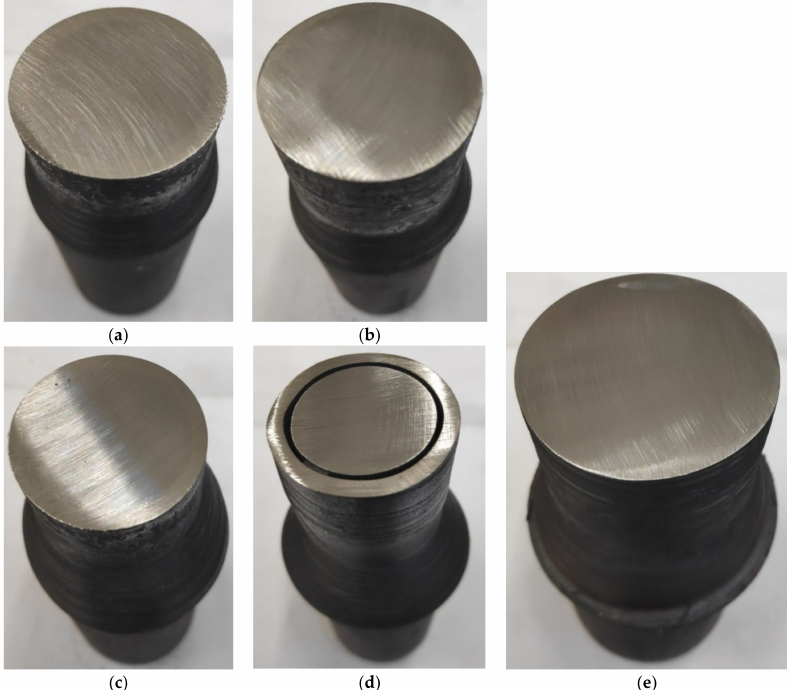
Figure 7. View of cross-sections of bimetallic rods: ( a ) variant I, ( b ) variant II, ( c ) variant III, ( d ) variant IV, ( e ) variant V of the